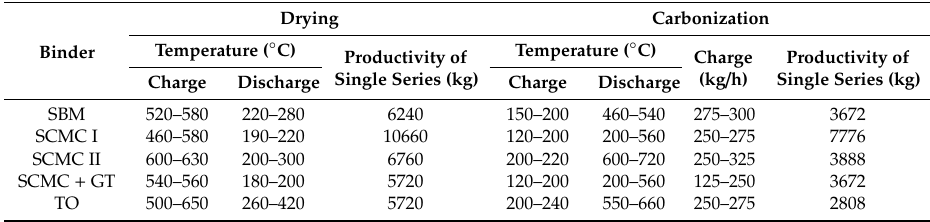
Table 2. Technological parameters of drying and carbonization.